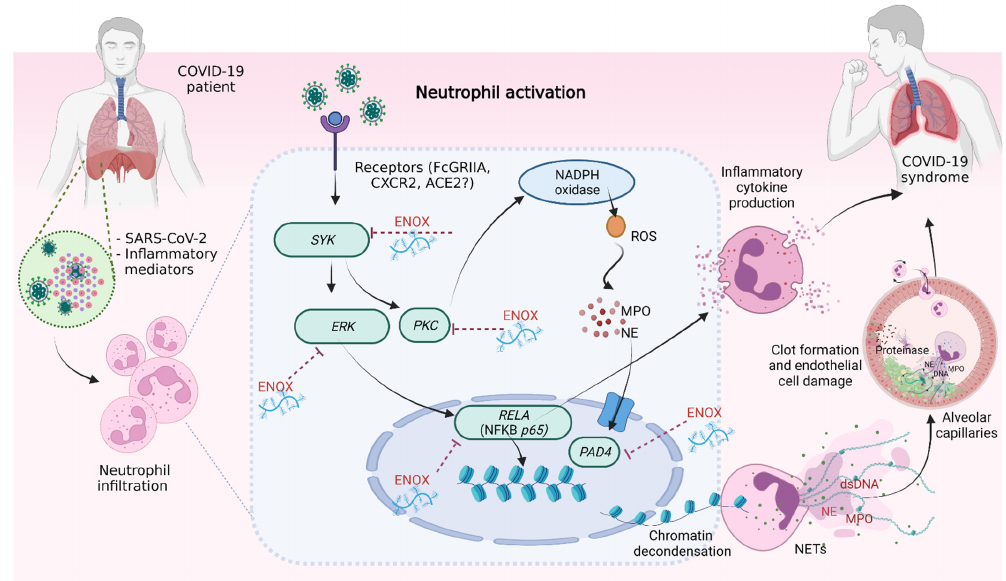
Figure 4 . The anti-inflammatory and inhibition of NET production by enoxaparin in COVID-19 in- fection. SARS-CoV2 virus and inflammatory mediators are recognized by receptors on the cell sur- face of neutrophils inside the lungs that activate inflammatory cytokine/chemokine release (e.g., IL- 8) and NET formation causing lung pathology. Intracellular molecules involved in neutrophil acti- vation include SYK , ERK and RELA (IL-8 production), PKC and PAD4 (NET formation), which are inhibited by enoxaparin prophylaxis. Abbreviations: RELA , REL-associated protein involved in NF- κ B p65 subunit; nuclear factor kappa B, NF- κ B; Protein kinase C, PKC ; Spleen tyrosine kinase, SYK ; Extracellular signal-regulated kinases, ERK ; Protein arginine deiminase 4, PAD4 ; Enoxaparin, ENOX; Angiotensin-converting enzyme 2, ACE2; severe acute respiratory syndrome coronavirus 2, SARS-CoV-2; Reactive oxygen species, ROS; Fc-gamma receptor IIA, FcGRIIA; C-X-C Motif Chem- okine Receptor 2, CXCR2; Myeloperoxidase, MPO; Neutrophil elastase, NE; Double-strand DNA, dsDNA.